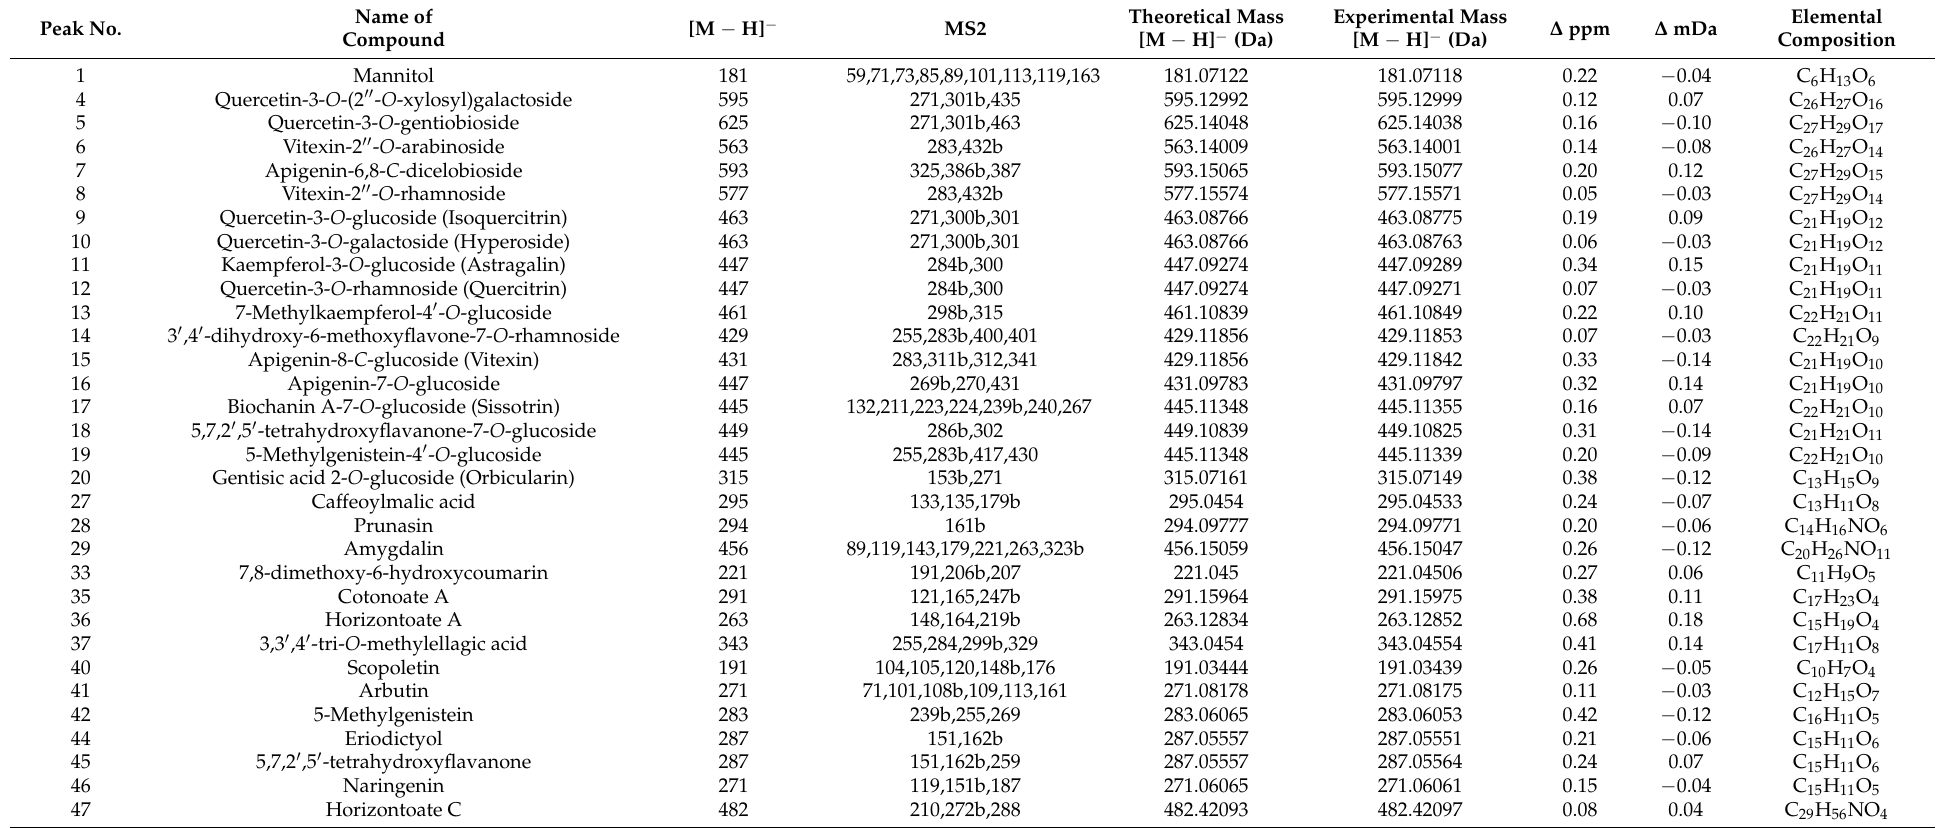
Table 2. High-resolution mass spectrometry (HR-MS) of [M − H] − ion and MS2 data. Peak